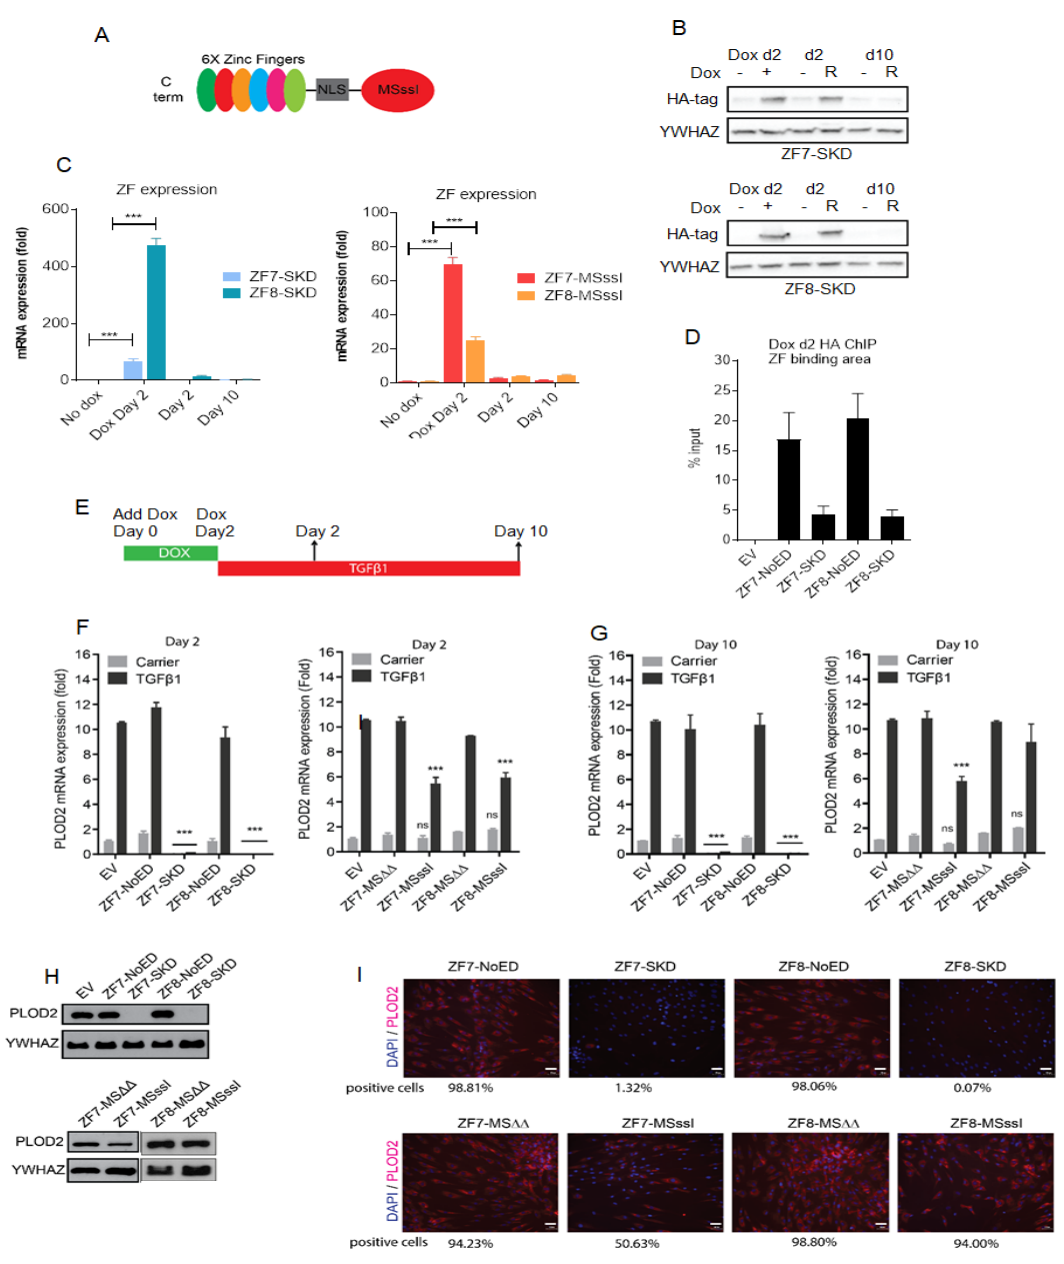
Figure 2. Zinc finger mediated targeting of SKD or M.SssI to the PLOD2 promoter. ( A ) Schematic representation of the DNA methylation editors containing M.SssI (or derivates) C-terminally fused